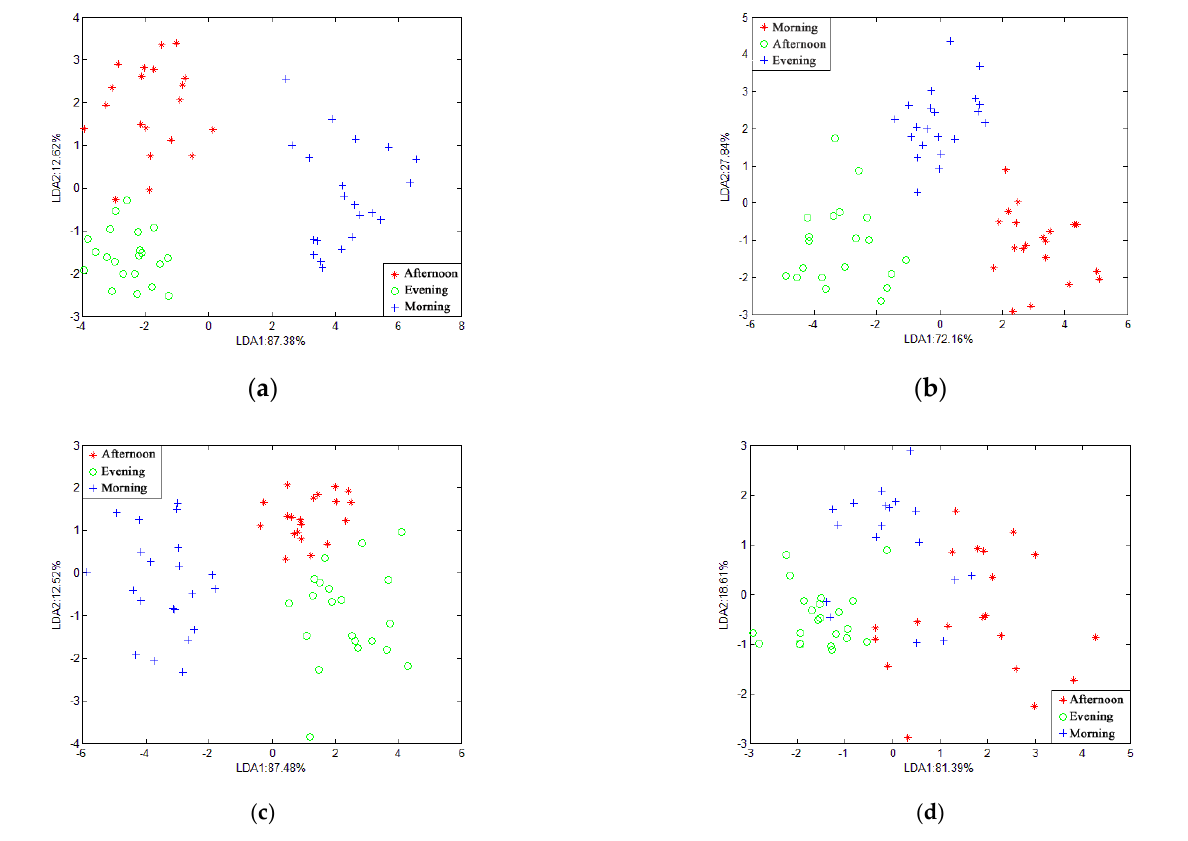
Figure 5. LDA chart of different time at the same position in pig house with features of average values: ( a ) pregnancy-exhaust; ( b ) pregnancy-middle; ( c ) nursery-middle; ( d ) nursery-window.